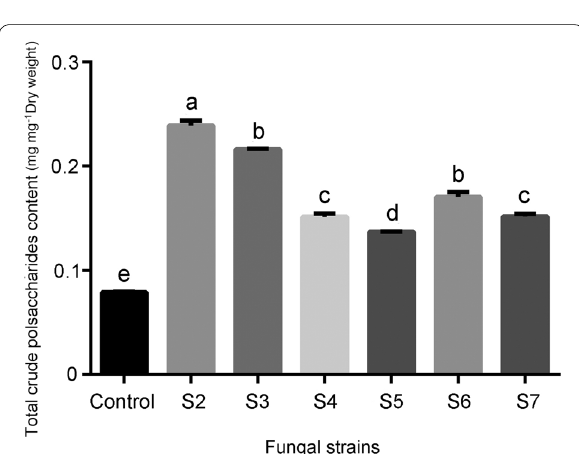
Fig. 5 Effect of fungal strains on total crude polysaccharides content in stems of D. officinale at 15 weeks after inoculation. Data are mean SE. Different letters above bars are significantly different at ± P < 0.05 (Fisher’s protected least significant difference